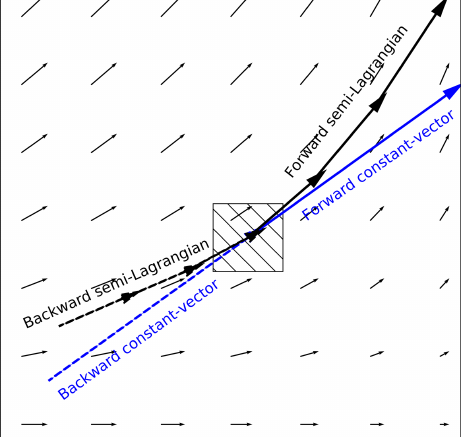
Figure 3. Displacement vectors of four proposed advection schemes: forward or backward constant vector and forward or back- ward